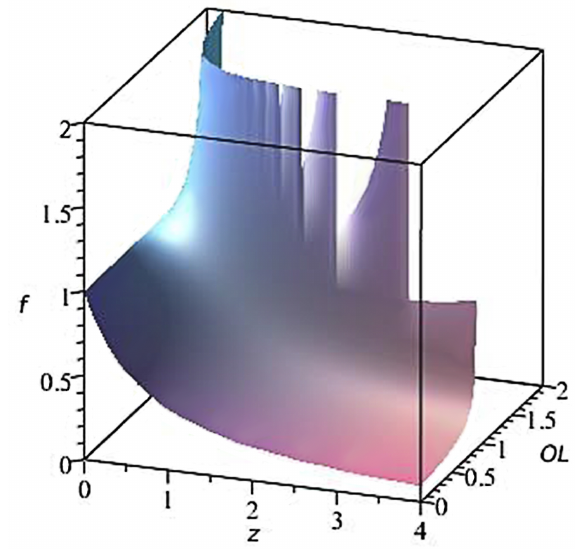
1 as a function of z and Ω Λ in the neighborhoods of the poles when Ω K E z p q